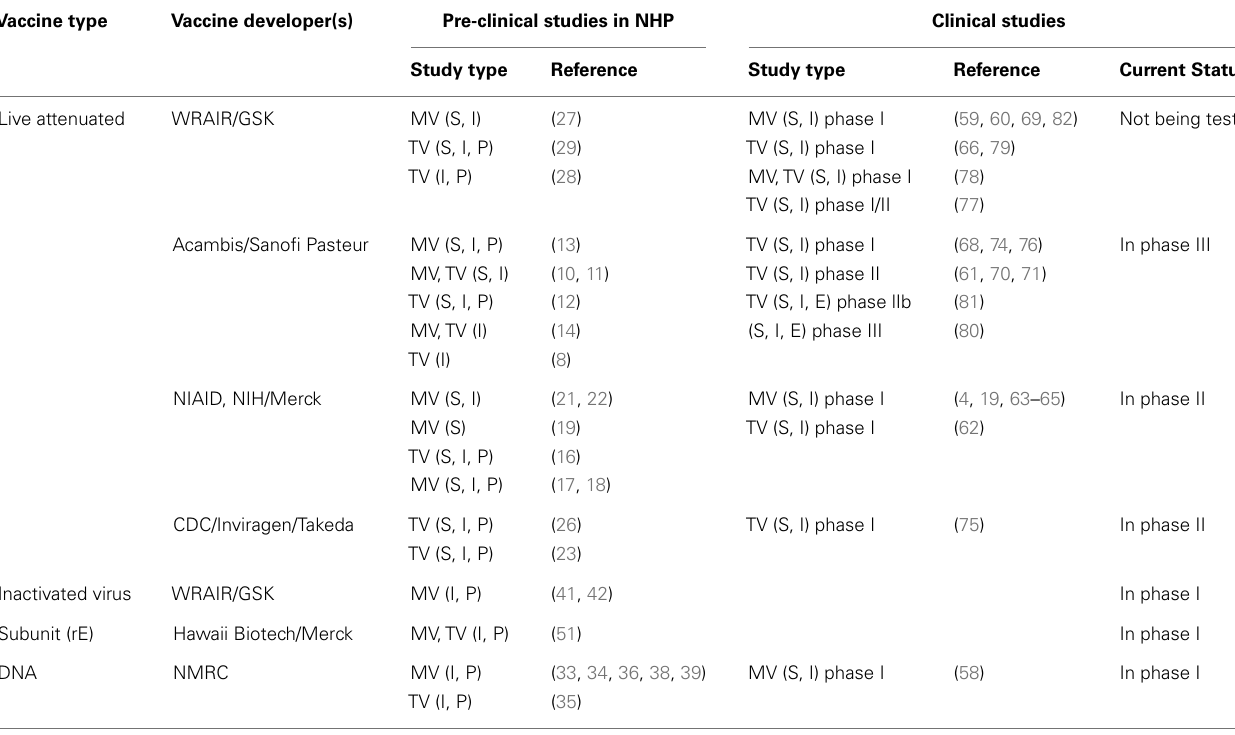
Table 1 | Dengue vaccine candidates in clinical development: NHP and clinical studies